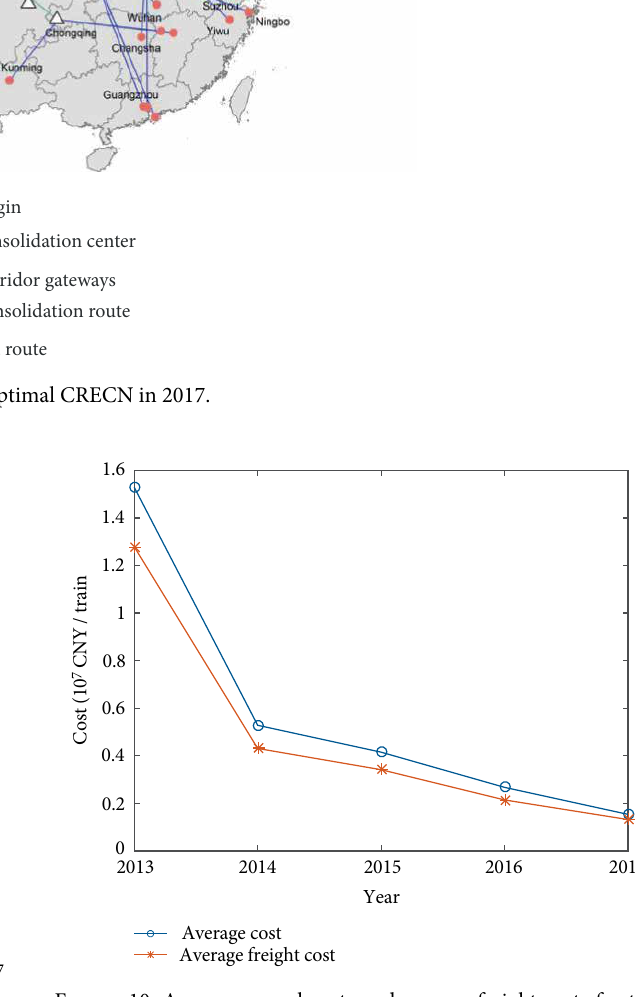
Figure 10: Average annual costs and average freight costs for the